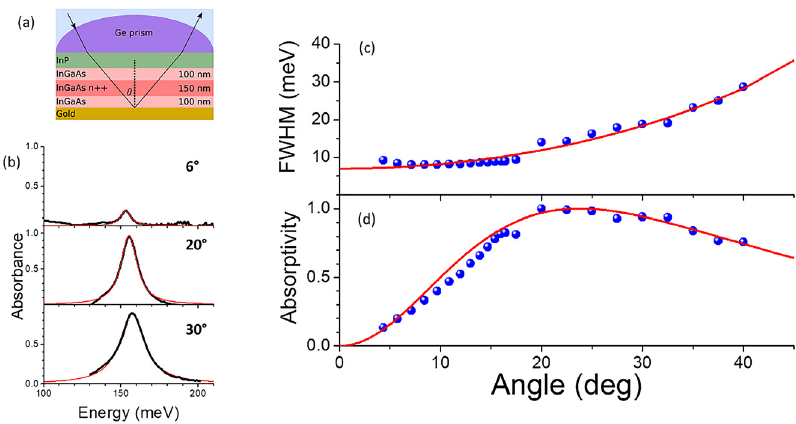
Figure 2: (a) Sketch of the sample and of the geometry used for reflectivity experiments. (b) Absorption spectra at three different internal angles (black lines) and Lorentzian fit of the resonances (red lines). (c) Full width at half the maximum (FWHM) of the absorption peak (blue symbols) as a function of the internal angle. Red line presents the calculated broadening, including radiative and nonradiative contribution. (d) Peak absorptivity extracted from the absorption spectra as a function of the angle, compared with the calculated one (red line) by using